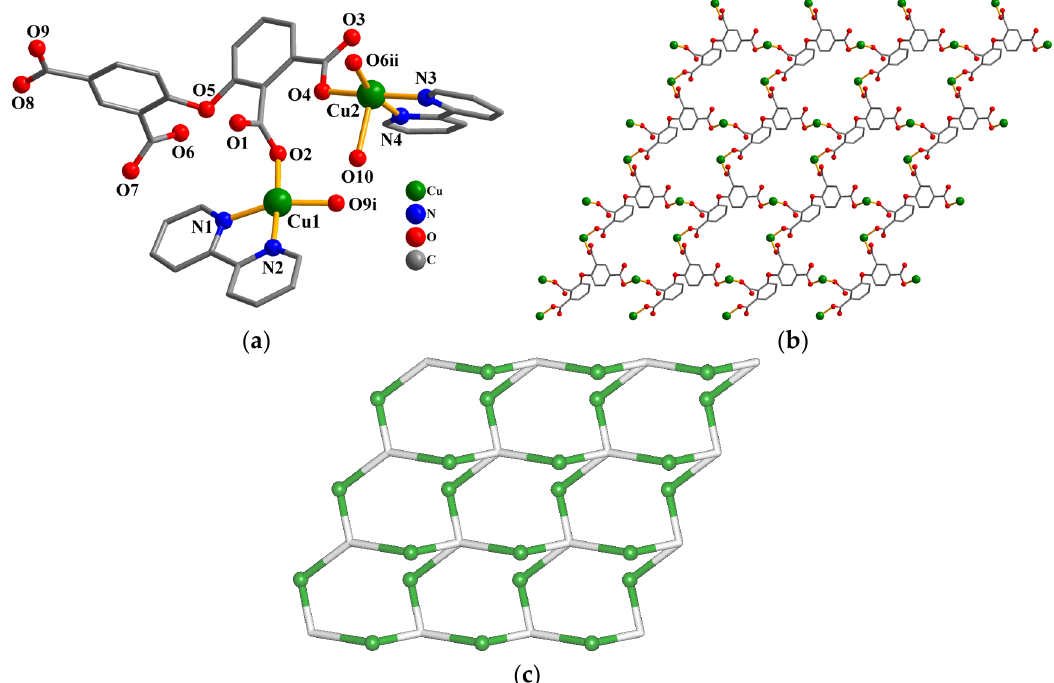
Figure 1. Structural fragments of 1 . ( a ) Coordination environment around Cu(II) atoms; H atoms are omitted for clarity. Symmetry codes: i = x + 1, y , z + 1; ii = x + 1, y , z . ( b ) 2D metal–organic layer; view along the b axis. ( c ) Topological view of 2D layer with a sql topology; view along the b axis; Cu centers (green balls), centroids of µ 4 -dpa 4 − nodes (gray).